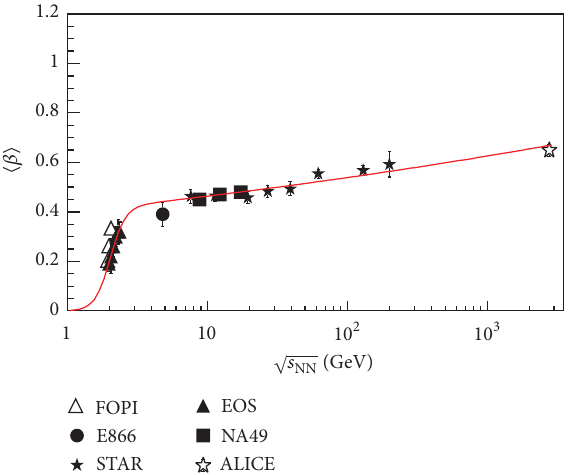
Figure 1: Kinetic freeze-out temperature as a function of centre-of- . Data are from [41, 42]. mass energy √ 𝑠 NN